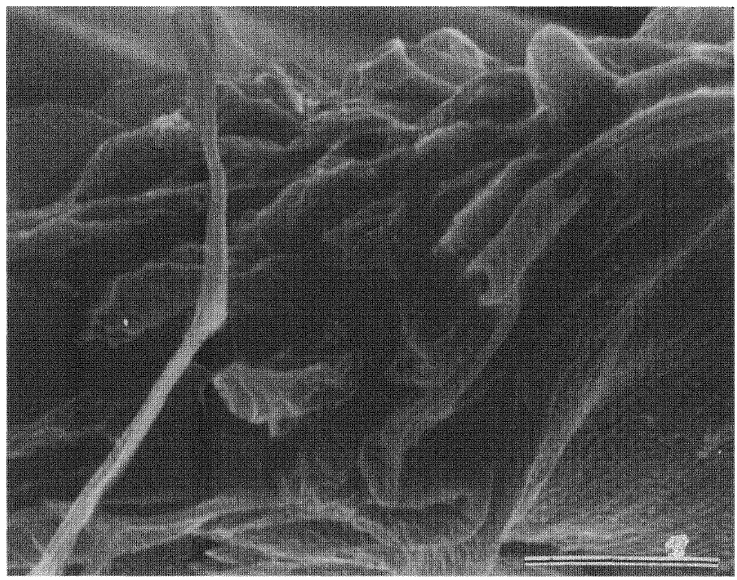
Fig. 7. Scanning electron micrograph of the distiphallus near the base of the gen- ital rod, showing possible apertures through which sperm may